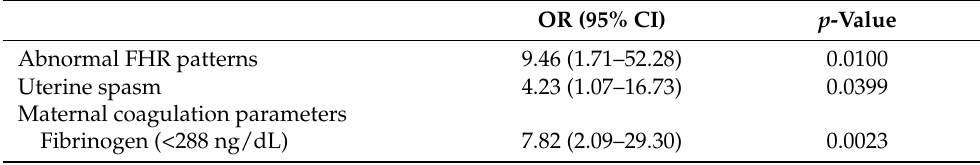
Table 4. Results of multivariate analysis in terms of risk factors of fetal acidemia.